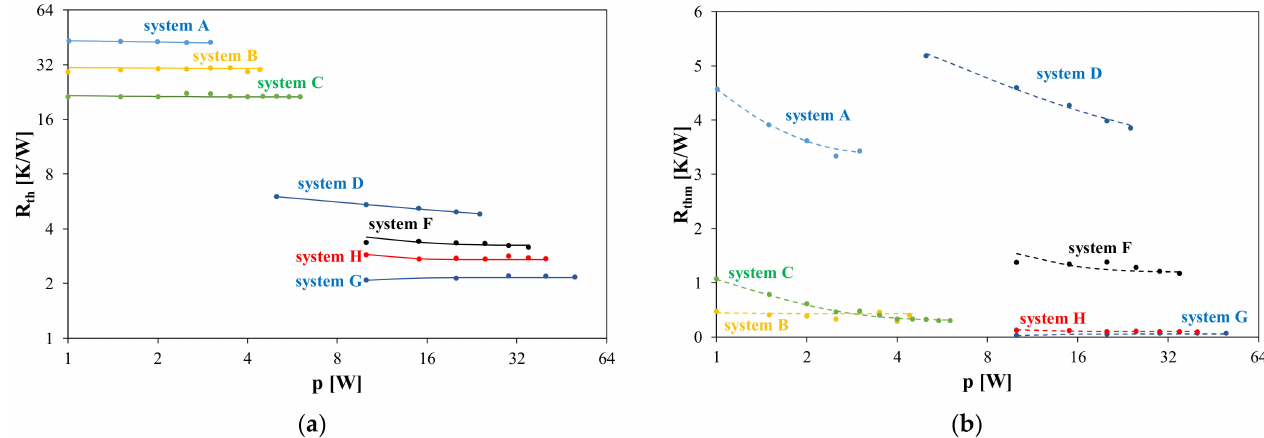
Figure 17. Measured and calculated dependences ( a ) R th (p) and ( b ) R thm (p) for the investigated cooling